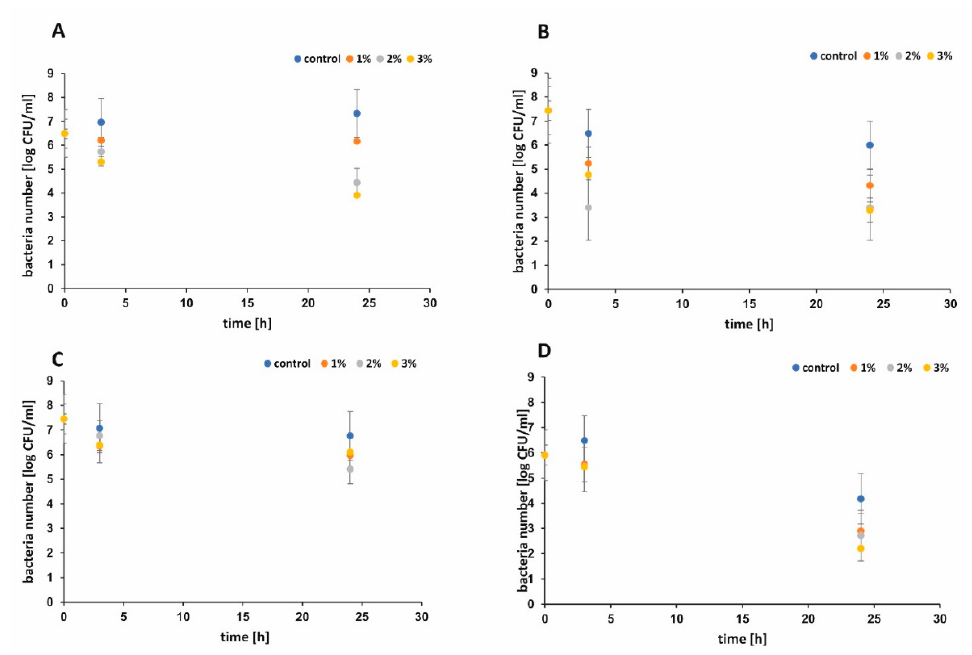
Figure 8. The bacterial survival rate [%] in contact with 1 wt %, 2 wt %, and 3 wt % h-BN-OH paper and control sample examined for varied bacterial suspension volumes: E coli 275 mL ( A ), E coli 55 mL ( B ), S. epidermidis 275 mL ( C ), and S. epidermidis 55 mL ( D ), after 3 and 24 h.